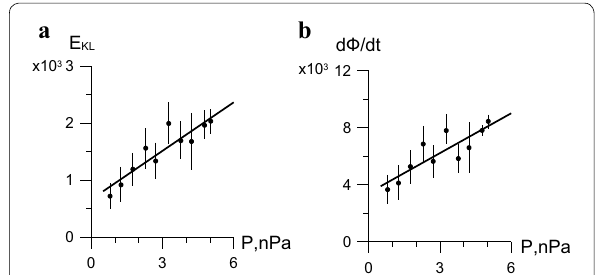
Fig. 4 Values of E KL and d Φ/ d t , which characterize the solar wind driving before the substorm expansive phase versus solar wind dynamic pressure. The dots represent the average values of the functions binned every 0.5 nPa, the vertical lines indicate the mean square deviation, and the solid lines represent the best linear